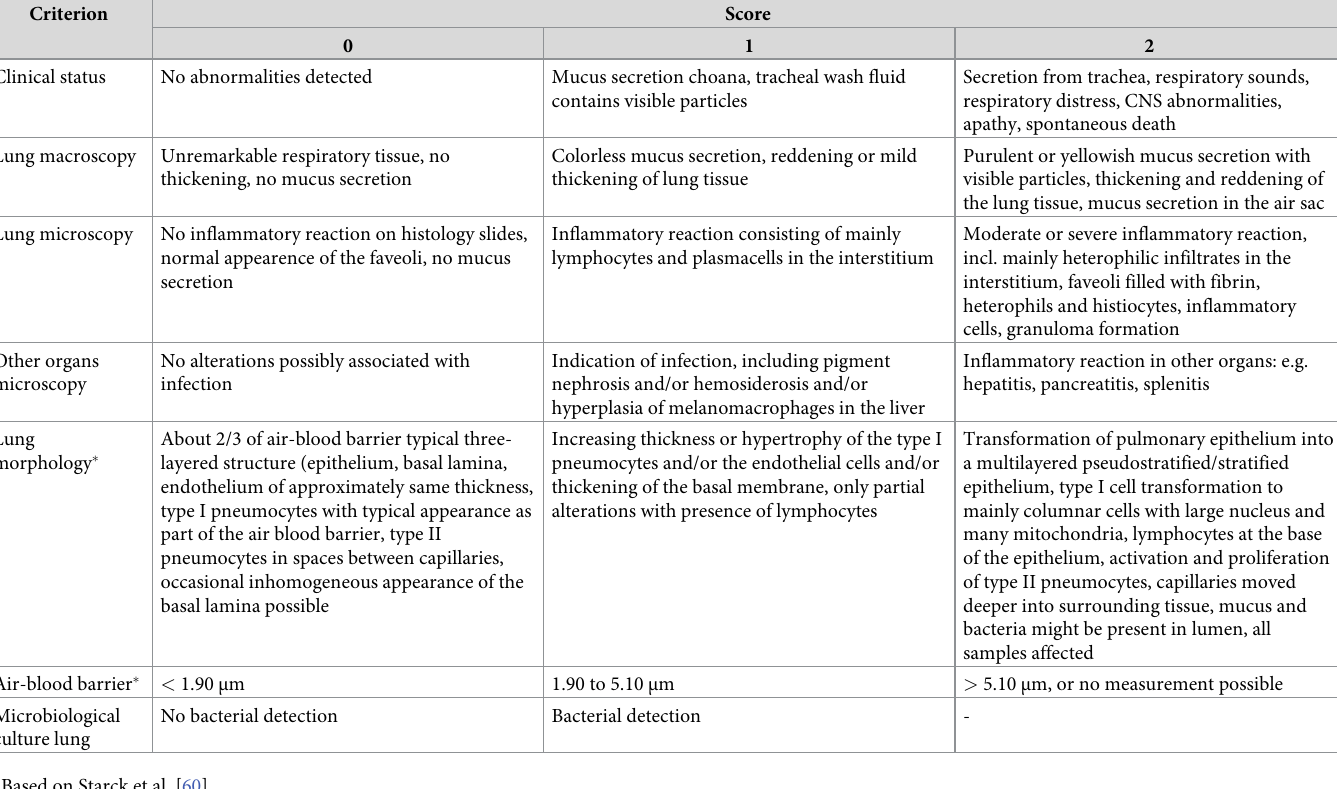
Table 1. Score definitions for different pathological criteria (for pathological alterations, only those signs are listed as relevant that were found in this study). Fur- ther details on the classification of the scores are provided in the text. Criterion Score